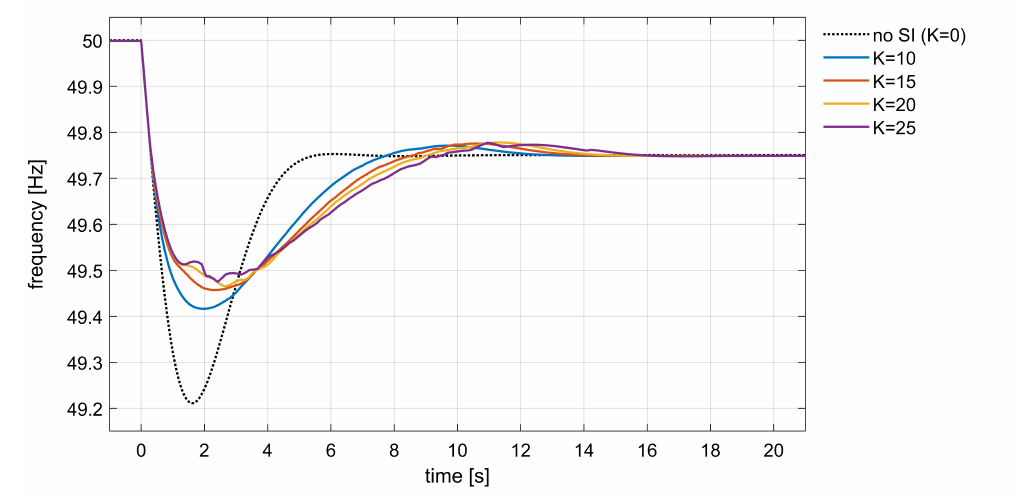
Figure 14. Real controller: frequency response with different gain K